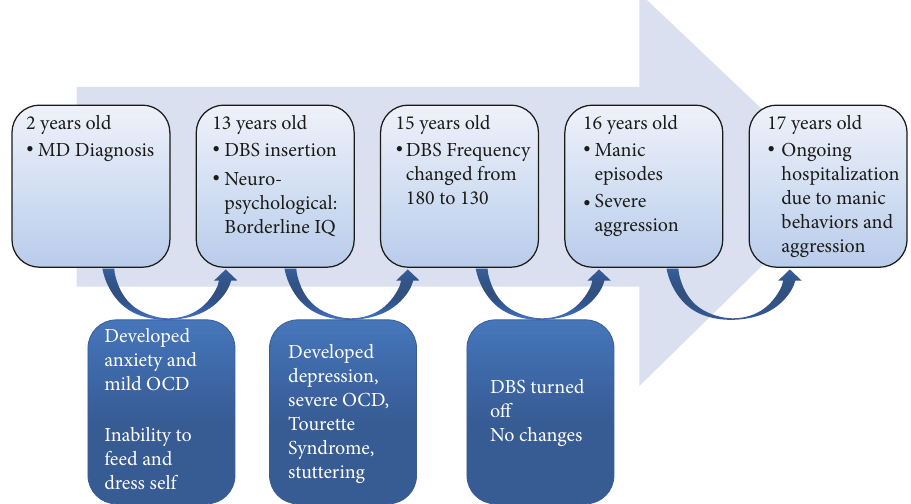
Figure 1: Timeline of progression of myoclonus dystonia, psychiatric, and behavioral